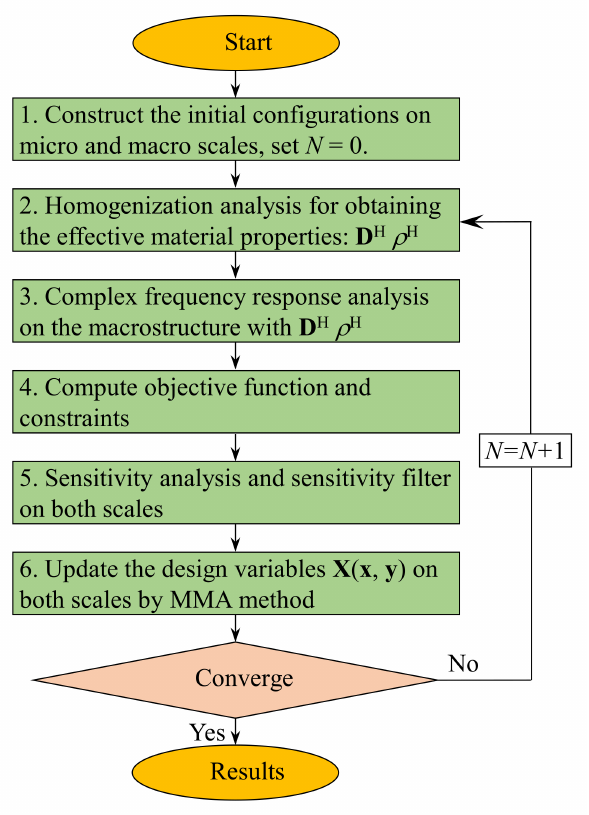
Figure 2. Flowchart of the concurrent topology optimization algorithm.